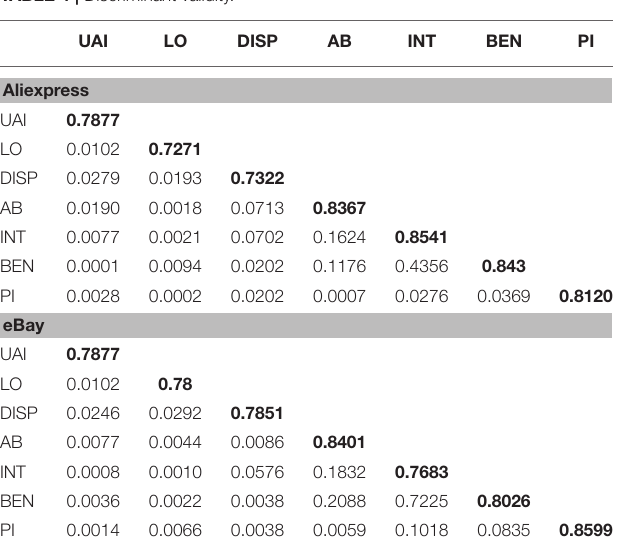
TABLE 4 | Discriminant